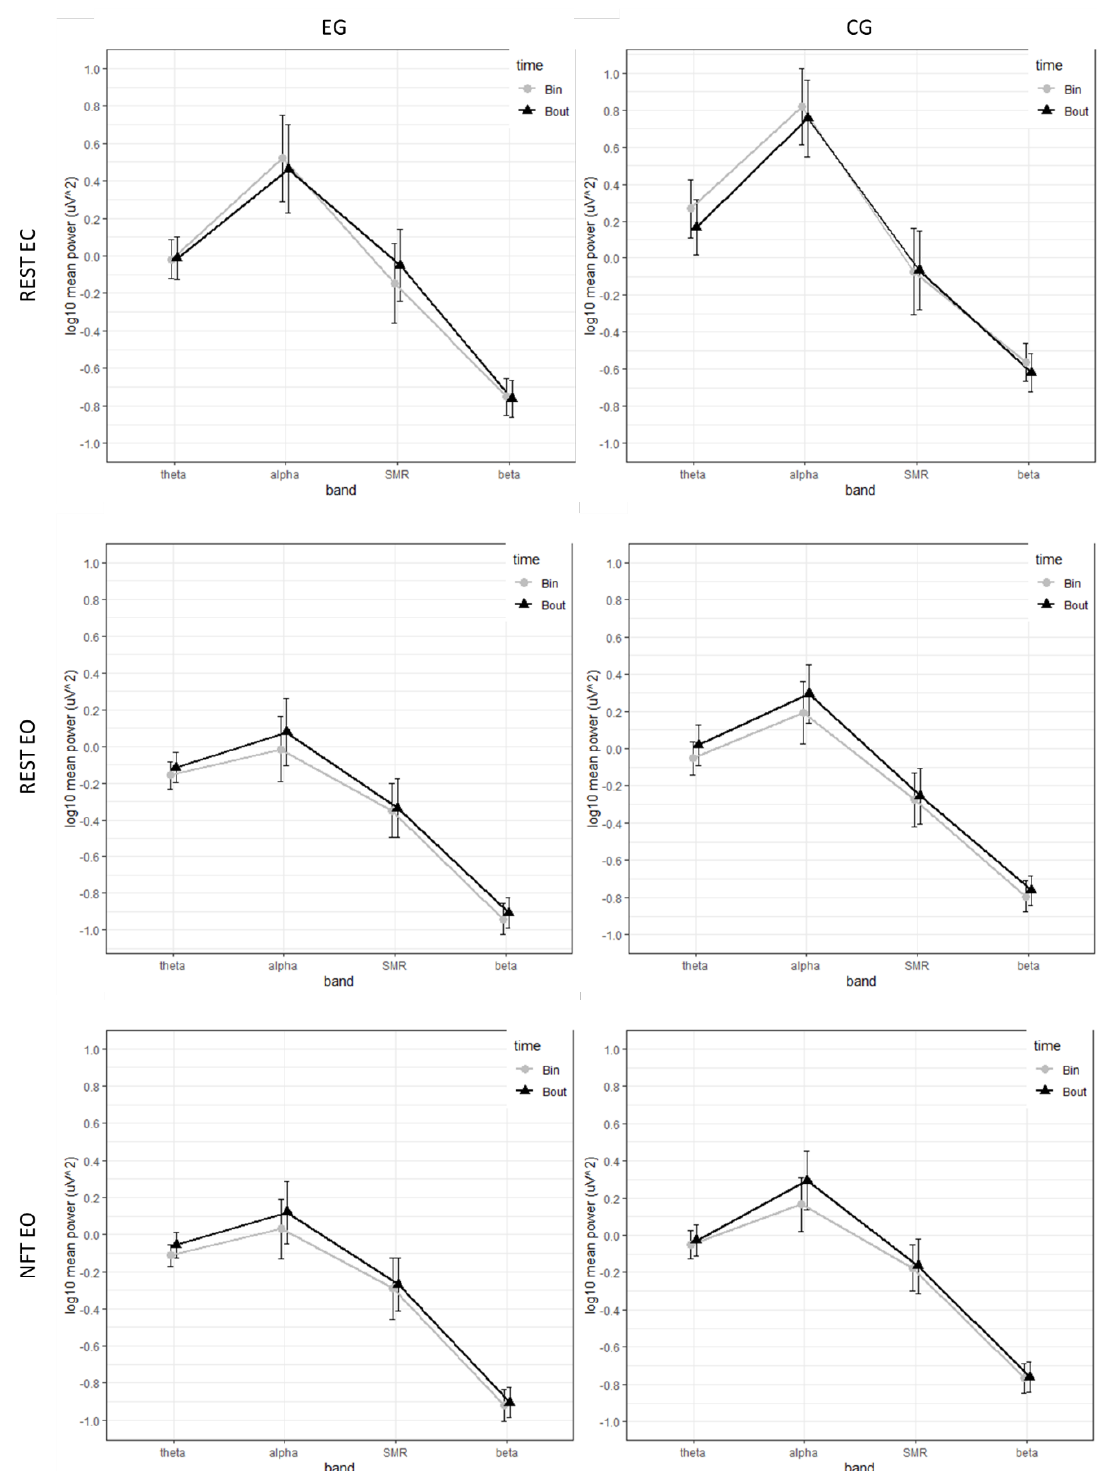
Figure 4. EEG power spectra at Bin and Bout. Estimated marginal means are log-transformed absolute power ( µ V 2 ) with 95% confidence intervals. During REST EC, both groups show reductions in alpha, CG also has reductions in theta, while EG increases SMR. While for the REST EO, both groups show up-regulation of alpha, similarly to the NFT EO task.